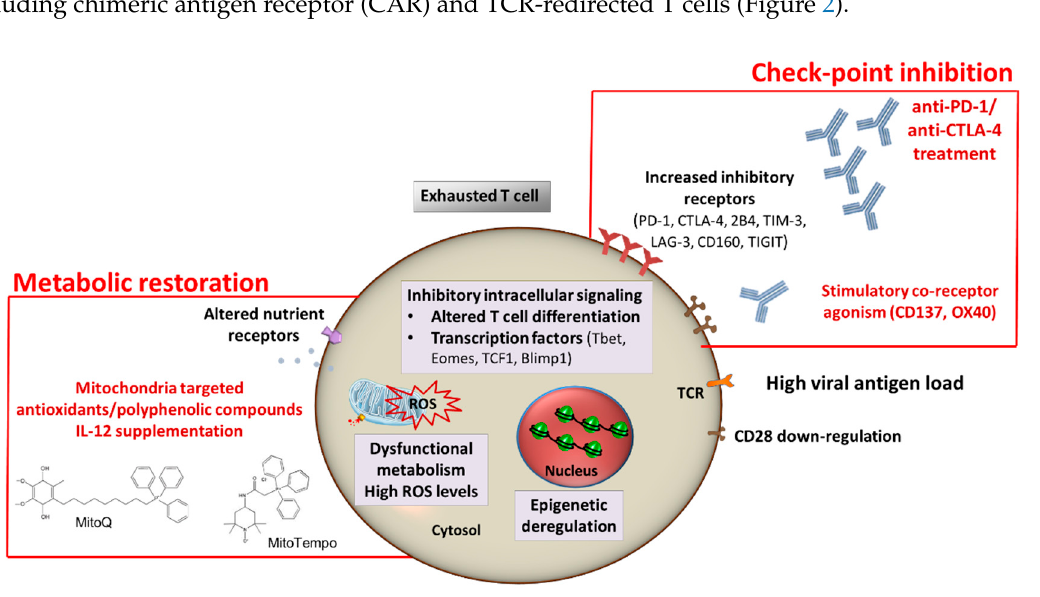
Figure 1. Hepatitis B virus- (HBV)-specific T cell restoration. Di ff erent mechanisms can simultaneously operate to inhibit the anti-viral T cell function, including the suppressive e ff ect of the liver environment amplified by inflammation and the high levels of antigenemia. Exhausted T cells are characterized by upregulation of multiple inhibitory receptors (e.g., PD-1, 2B4, LAG-3, CTLA-4, CD160, TIM-3, TIGIT), repressive transcriptional reprogramming (e.g., Tbet and TCF1 downregulation, Eomes and Blimp1 upregulation), broad metabolic alterations (impaired FAO, ROS overproduction and mitochondrial dysfunction), defective T cell e ff ector function (low cytokine production and reduced cytolytic function and proliferation) and memory development. Thus, promising approaches focused on restoring HBV-specific immunity are currently under investigation for chronically HBV infected patients, such as checkpoint blockade and metabolic